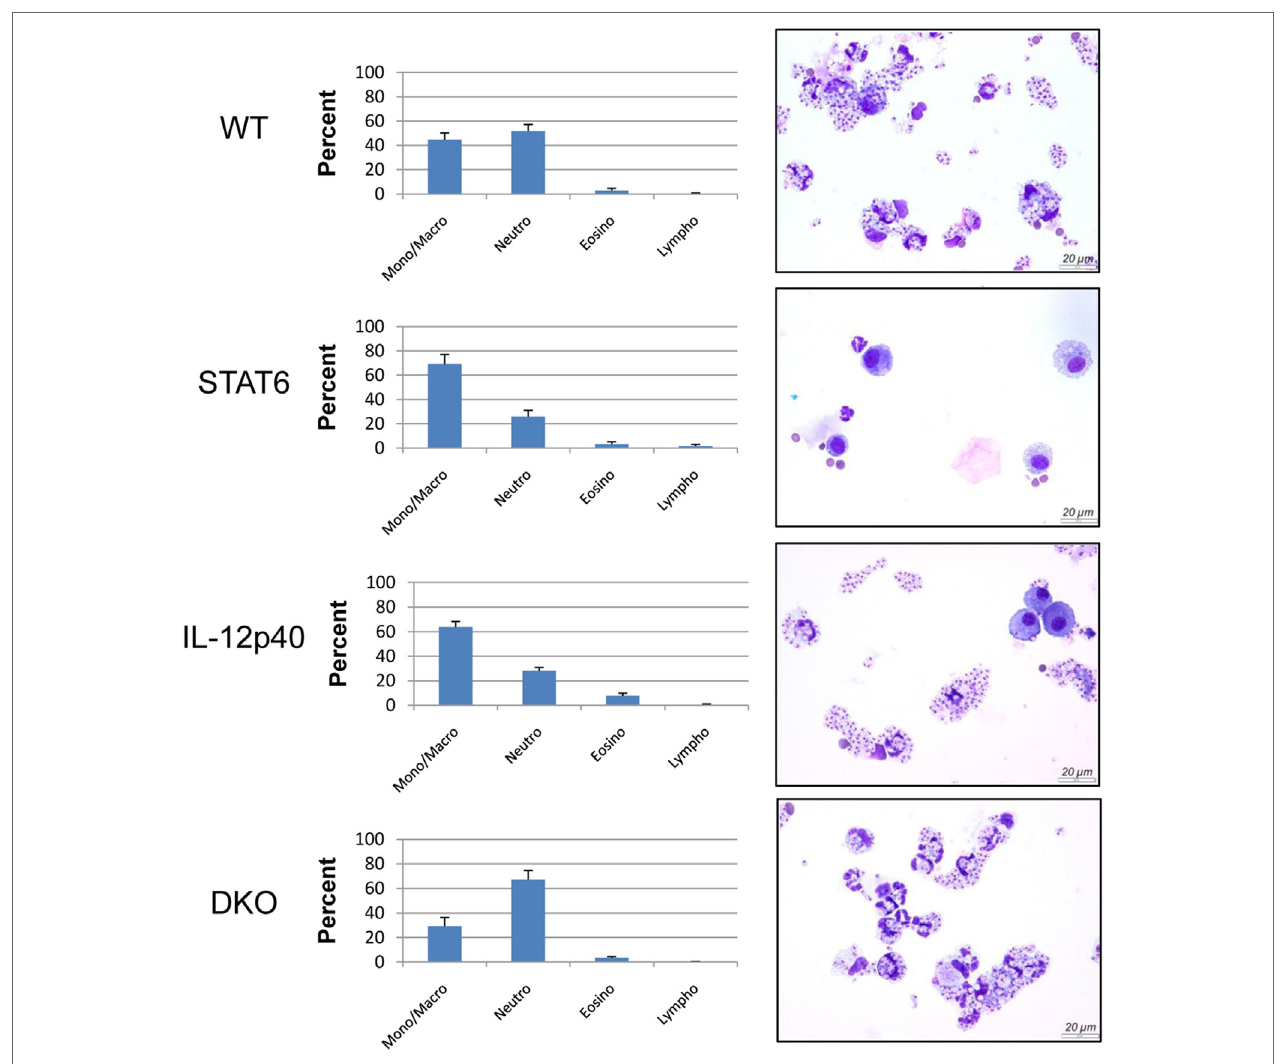
FigUre 5 | Majority of the cells present in double knockout (DKO) mice were neutrophils despite their altered phenotype. Wild type, IL-12p40 − / − , STAT6 − / − , and DKO BALB/c mice were infected with 2 × 10 6 metacyclic promastigotes. Footpads of infected mice at 25 post-infection were homogenized. Cytospins and Diff-Quick staining were performed and content was enumerated. Representative pictures of cytospins from the different groups were